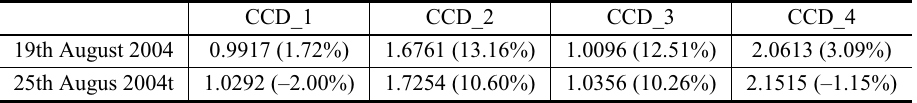
Calibration coefficients determined by Chinese researchers from the Gobi desert (China).